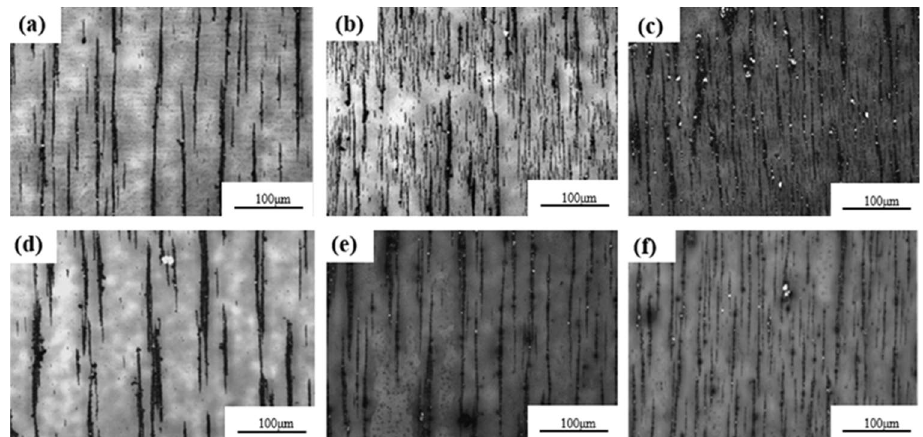
Figure 8. Ferrography of abrasive grains at different wear stages ( a – c , d – f are 30 mm tooth width, 10 mm tooth width corresponding to the ferrogram analysis of Stage A, B, and C).